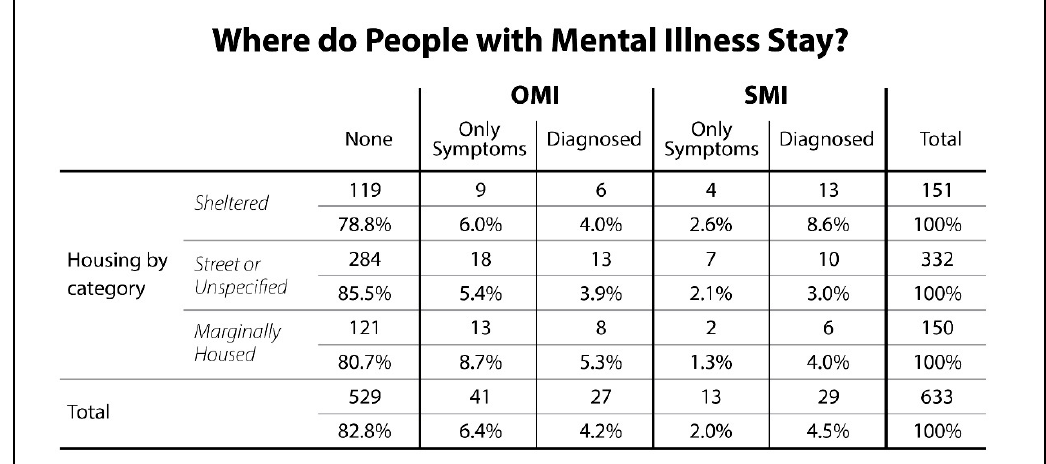
Figure 4. By Authors. SMI = Serious Mental Illness; OMI = Other Mental Illness.